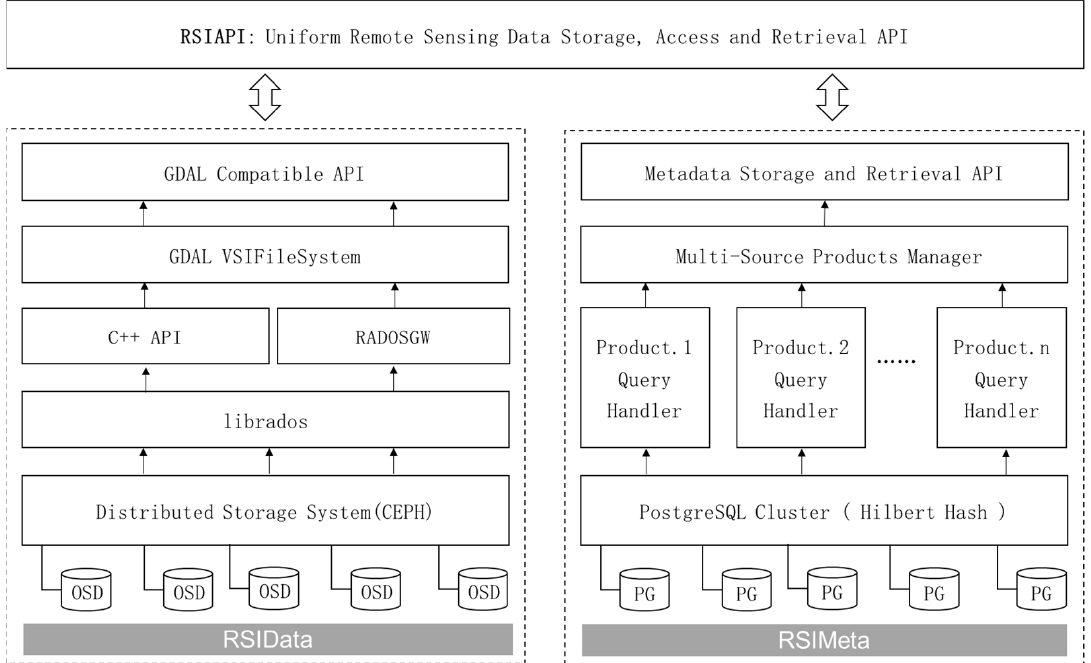
Figure 1. The overall architecture of RSIMS.